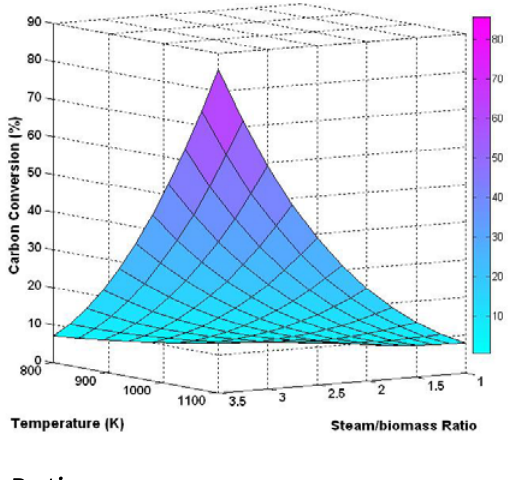
Figure 6. Surface plot of carbon conversion for different temperatures and steam/biomass ratios. Biomass feed rate: 0.072 kg/h; Sorbent/biomass ratio: